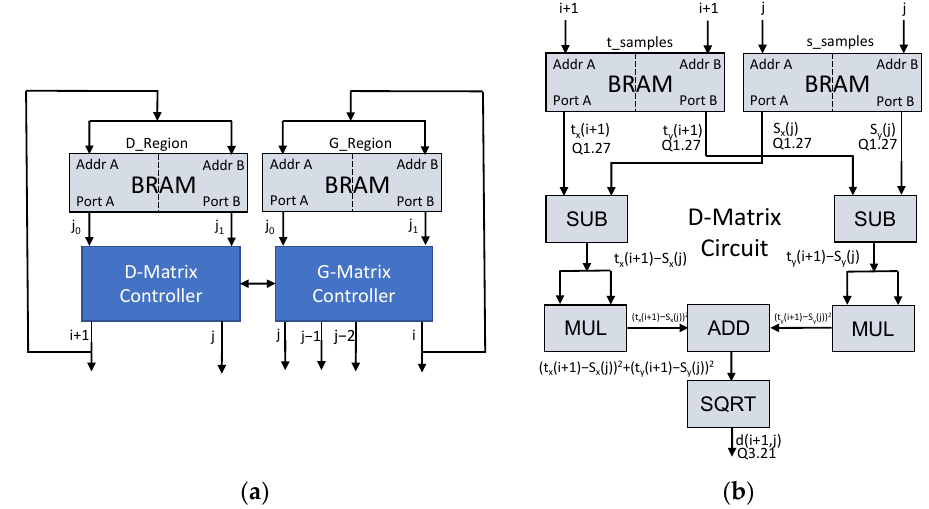
Figure 8. ( a ) Controller unit; ( b ) datapath of the D matrix computing circuit.